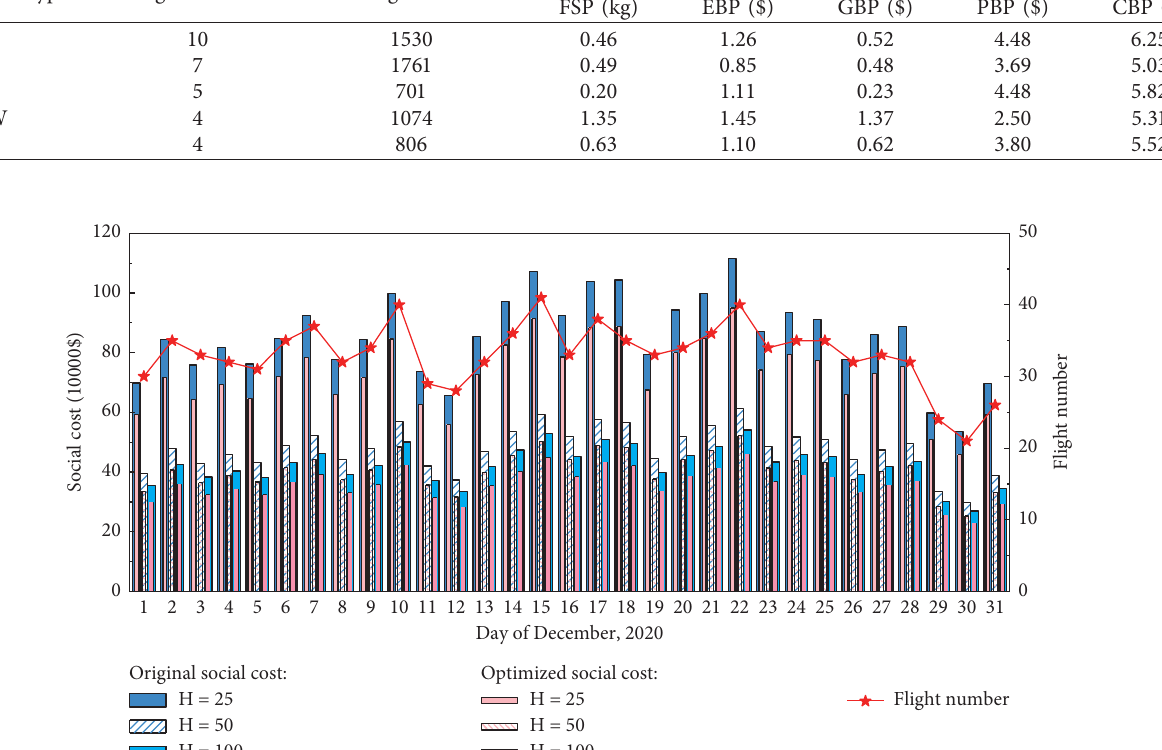
Table 4: The statistics of flights and per capita performance of SATO for different aircraft types on December 1, 2020. Aircraft type Flight number